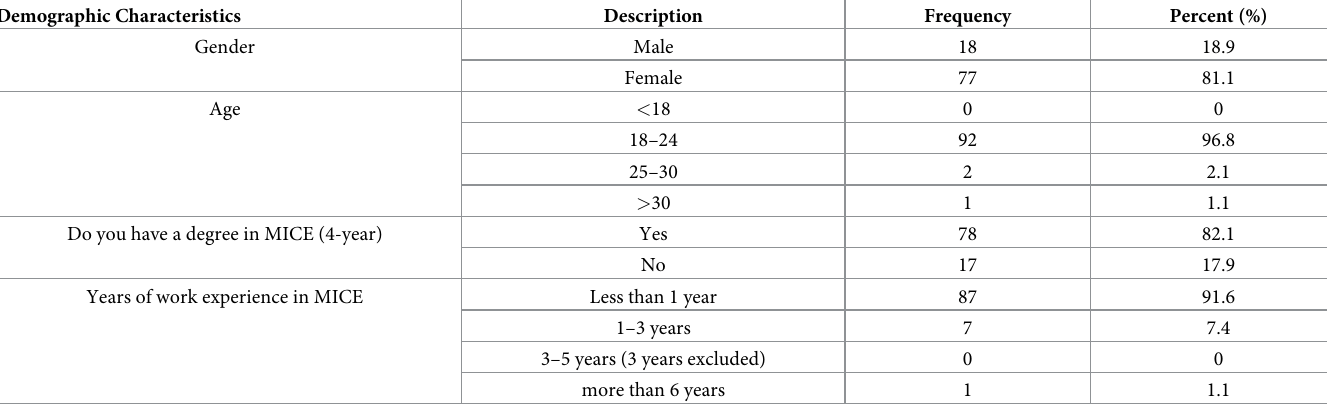
Table 1. Social-demographic information of the survey sample (N = 95). Demographic